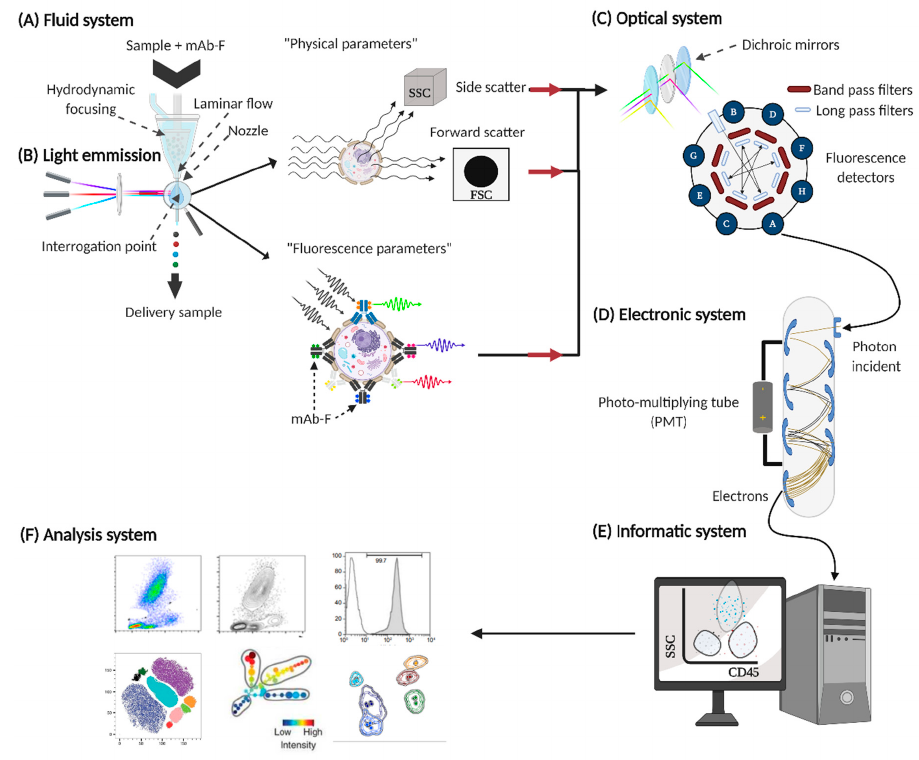
Figure 2. Fundamental systems in flow cytometers. For the proper functioning of the flow cytometer, six basic systems are required: ( A ) fluid system, ( B ) source of light emission, ( C ) optical system, ( D ) electronic system, ( E ) informatic system, and ( F ) analysis system.